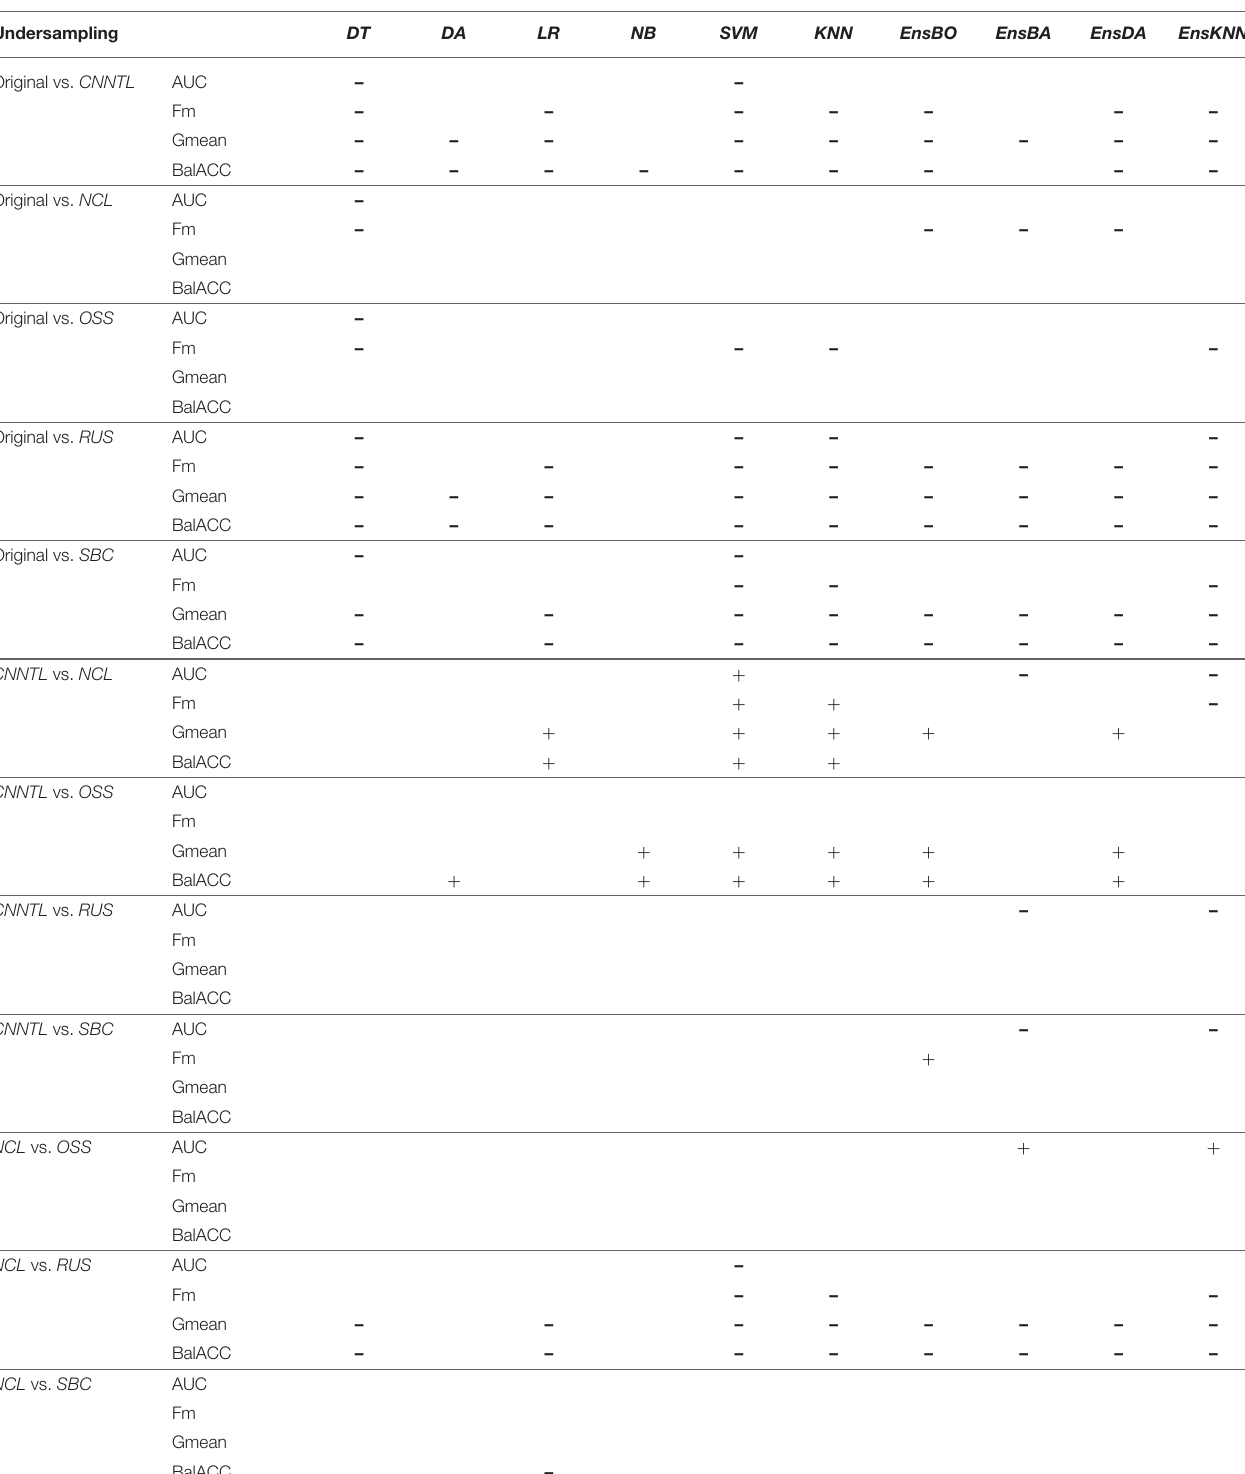
TABLE 4 | Friedman’s and post-hoc Shaffer’s test for the undersampling techniques applied to the four performance measures: AUC, Fm, Gmean, and BalACC. Undersampling